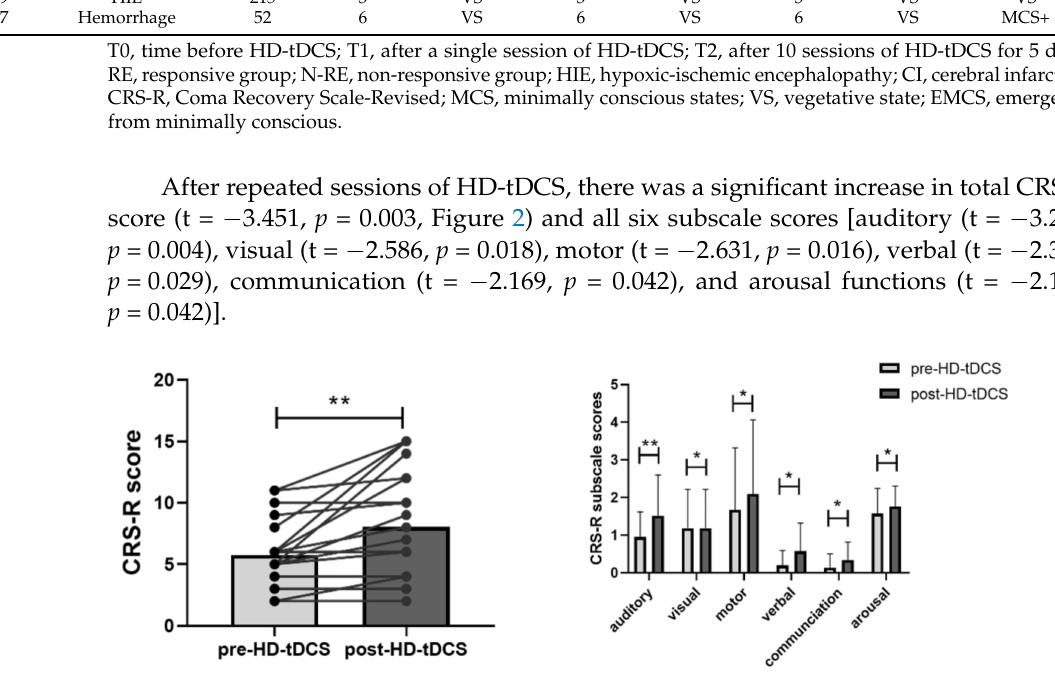
Figure 2. Changes in total CRS-R score and CRS-R subscale scores after HD-tDCS. CRS-R, Coma Recovery Scale-Revised; * p < 0.05; ** p <